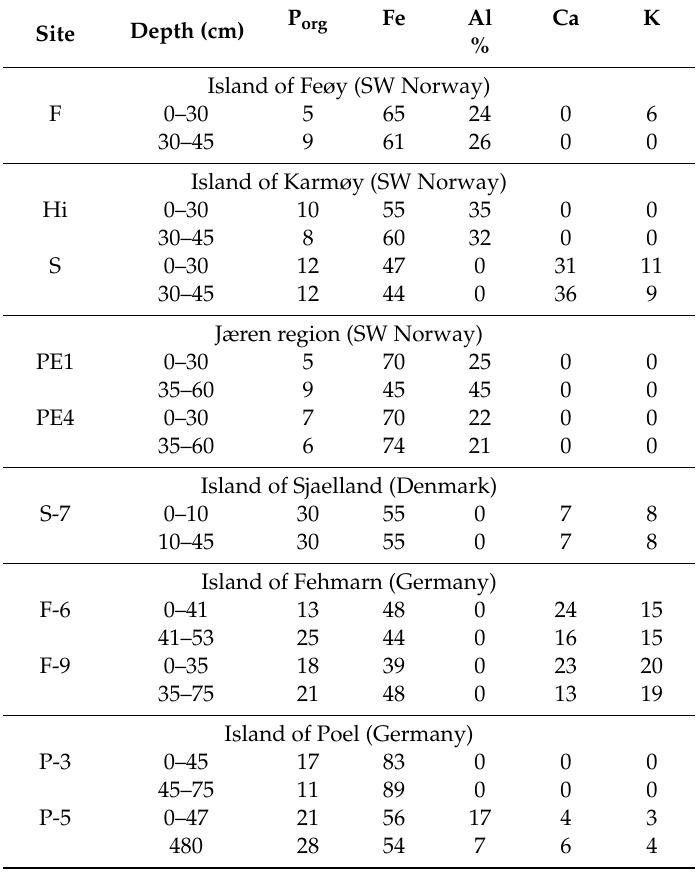
Table 3. Relative proportions of P species determined by P K -edge XANES spectroscopy. Goodness of fit: r-factor = 0.001 to